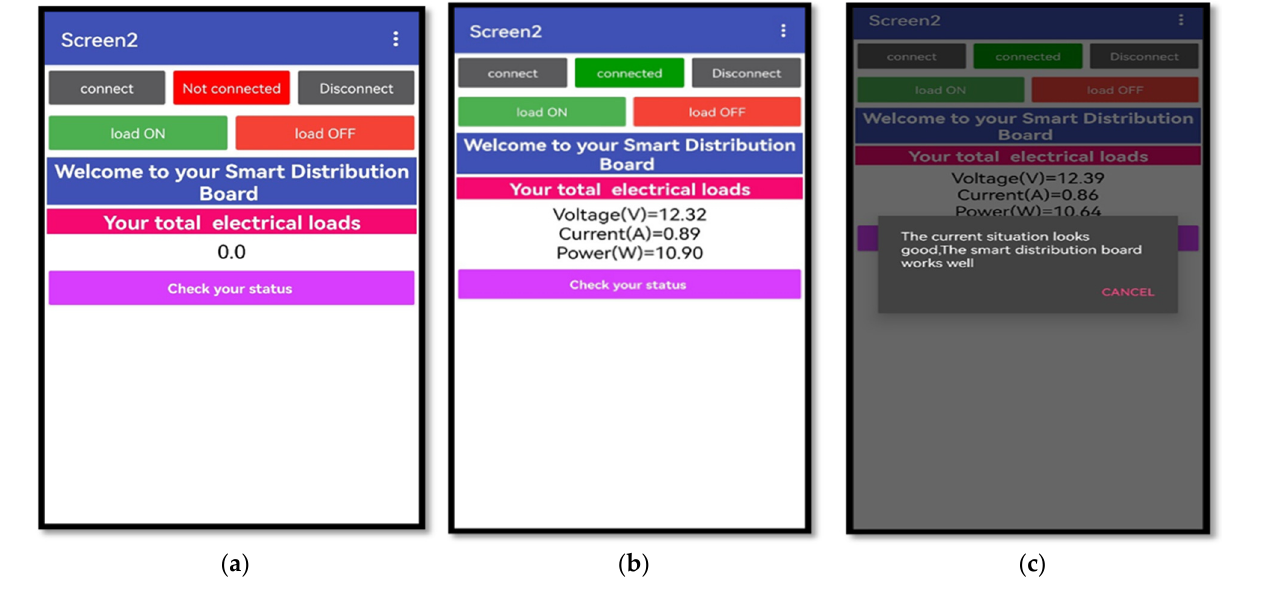
Figure 10. ( a ) Log in to the application using the user’s fingerprint, ( b ) data appears in the app after connecting Bluetooth, ( c ) current user status.